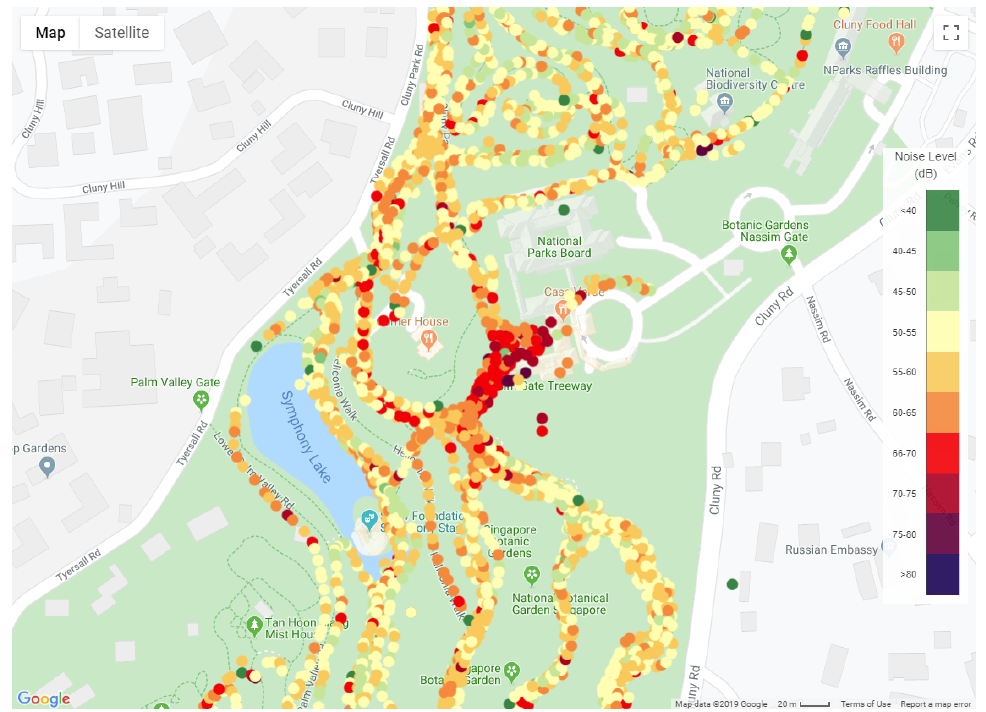
Figure 3: The noise map of the centre portion of the Singapore Botanic Gardens near the Nassim Gate (enlarged view of the middle portion of Figure